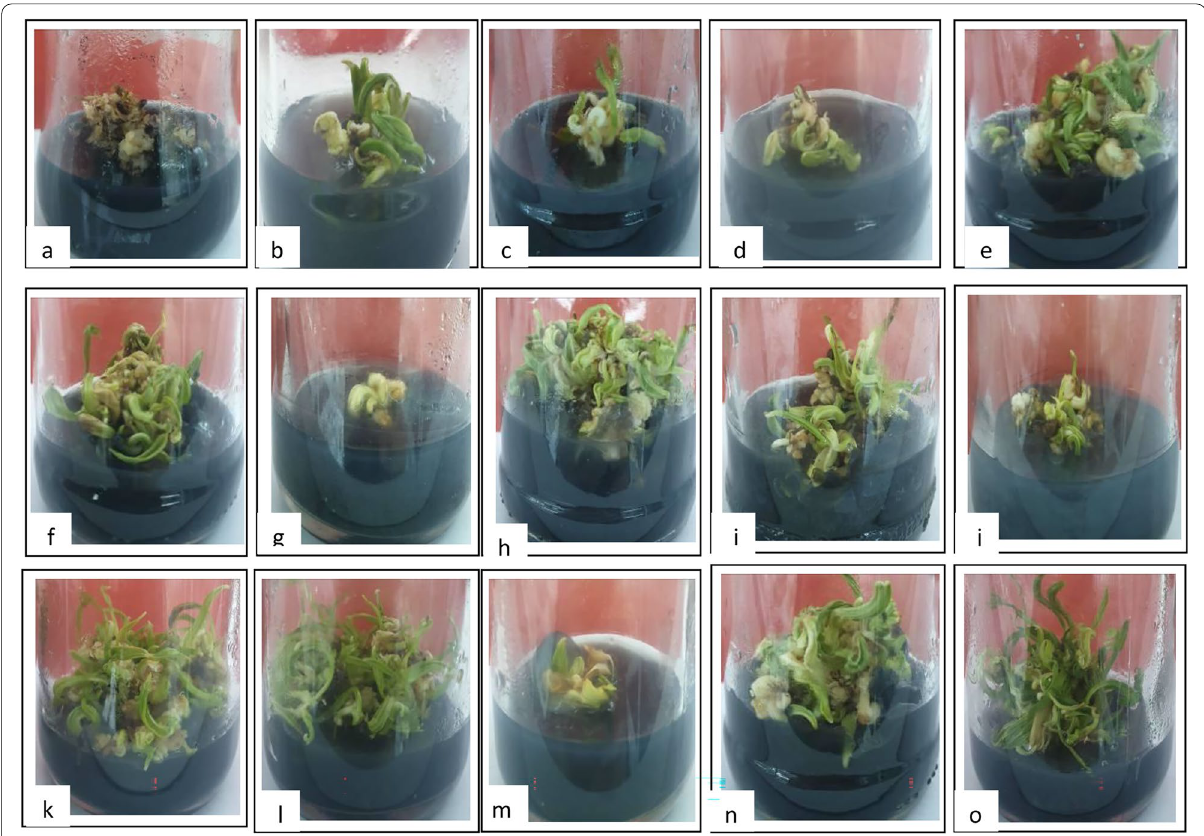
Fig. 2 Initiation of multiple shoot formation after 12 weeks of culture on MS media supplemented with chitosan (CHT) alone or in combination with thidiazuron (TDZ): mgL − 1 : a control, b 0 CHT 0.0 TDZ, h 10 CHT + 0.5 TDZ, o 20 CHT